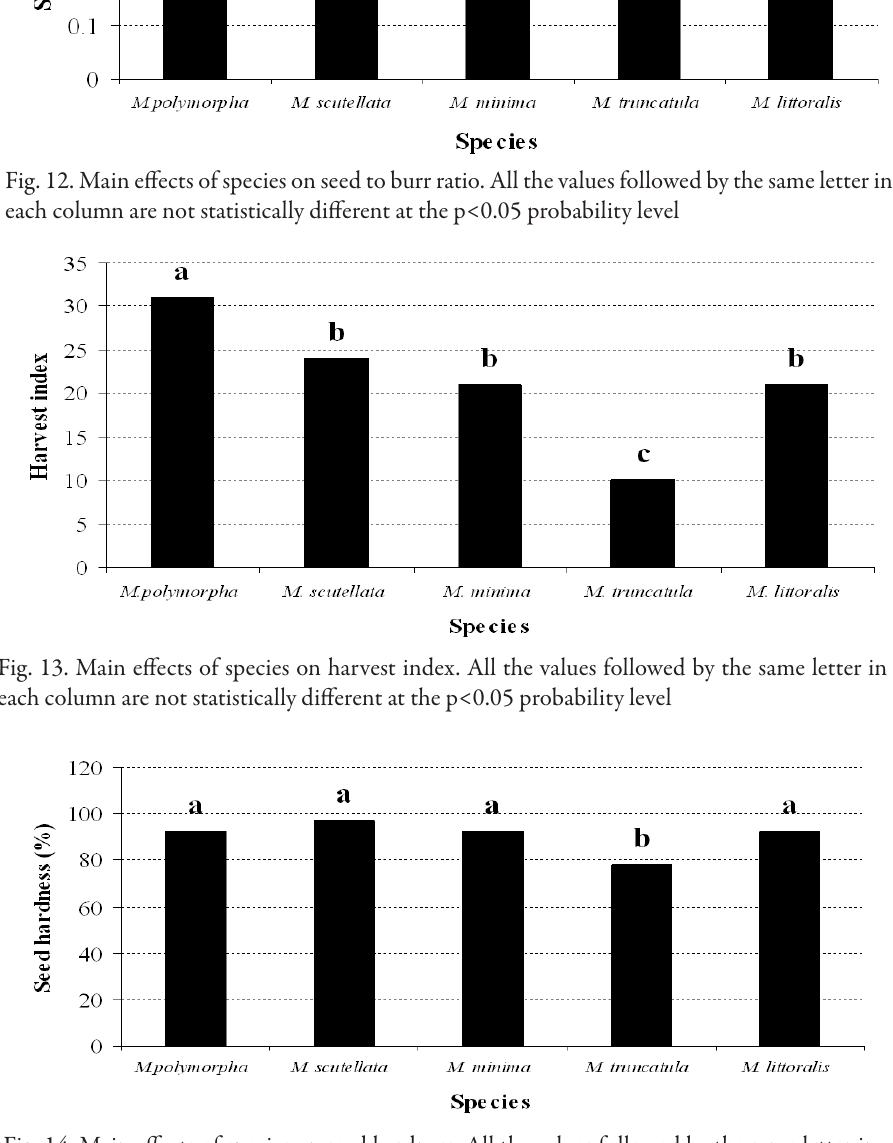
Fig. 14. Main effects of species on seed hardness. All the values followed by the same letter in each column are not statistically different at the p<0.05 probability